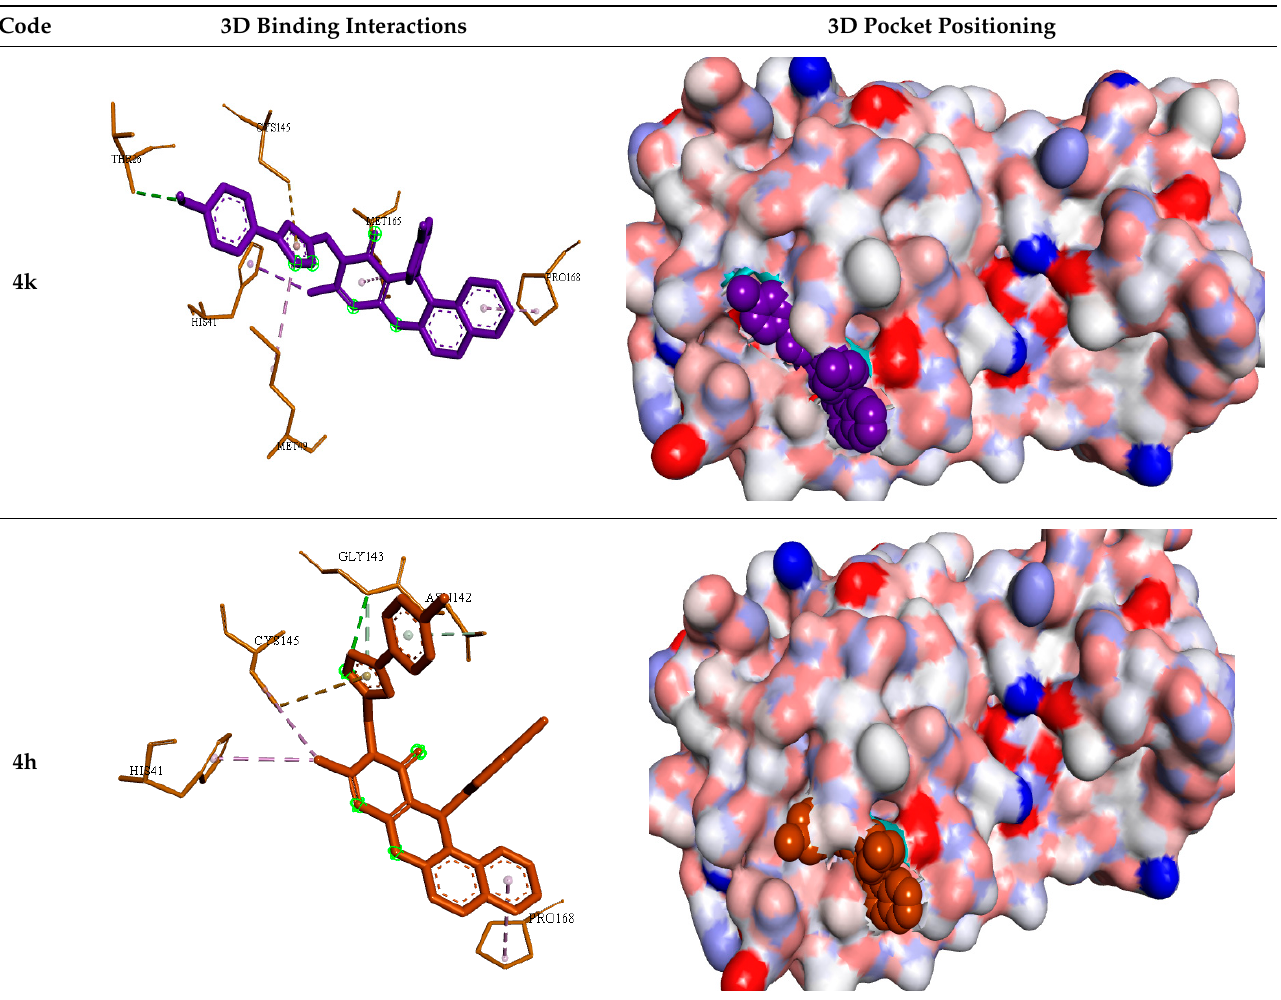
Table 4. 3D representations showing the binding interactions and positioning between the three promising tested com- pounds ( 4k , 4h and 4j ) and the N3 -binding pocket.